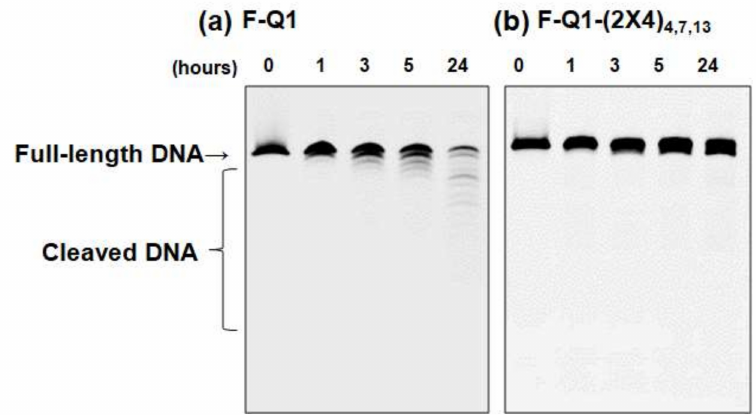
Figure 6. Denaturing gel electrophoresis of ( a ) F-Q1 and ( b ) F-Q1-(2X4) 4„7,13 after the addition of human serum at 37 ◦ C. Samples incubated for 0, 1, 3, 5, and 24 h were loaded on lanes one to five,